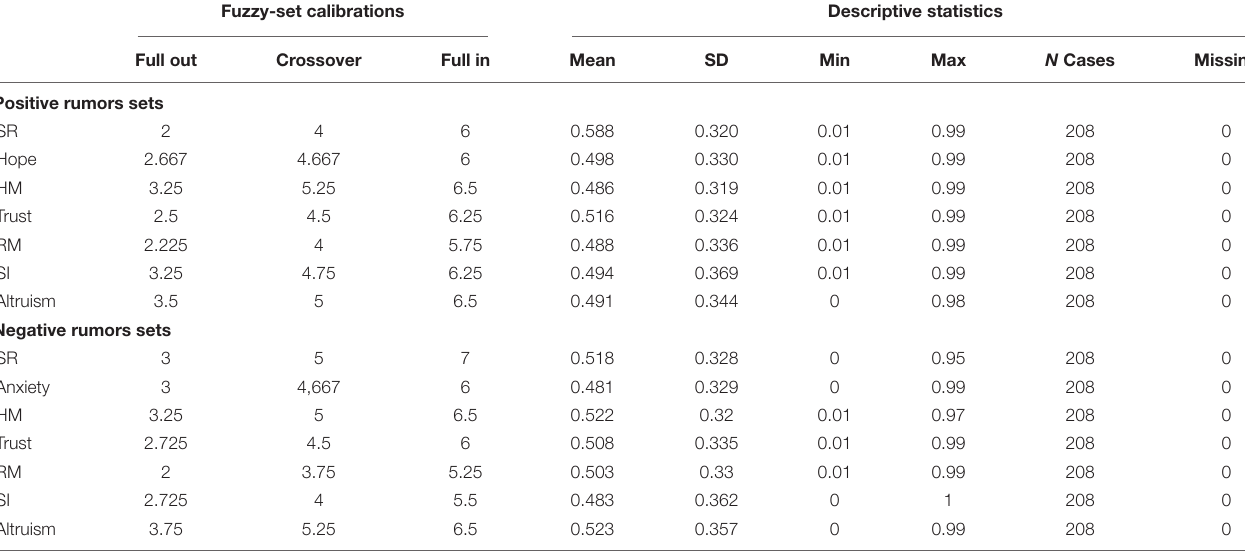
TABLE 2 | Sets, calibrations and descriptive statistics after calibrations regarding positive and negative rumours.